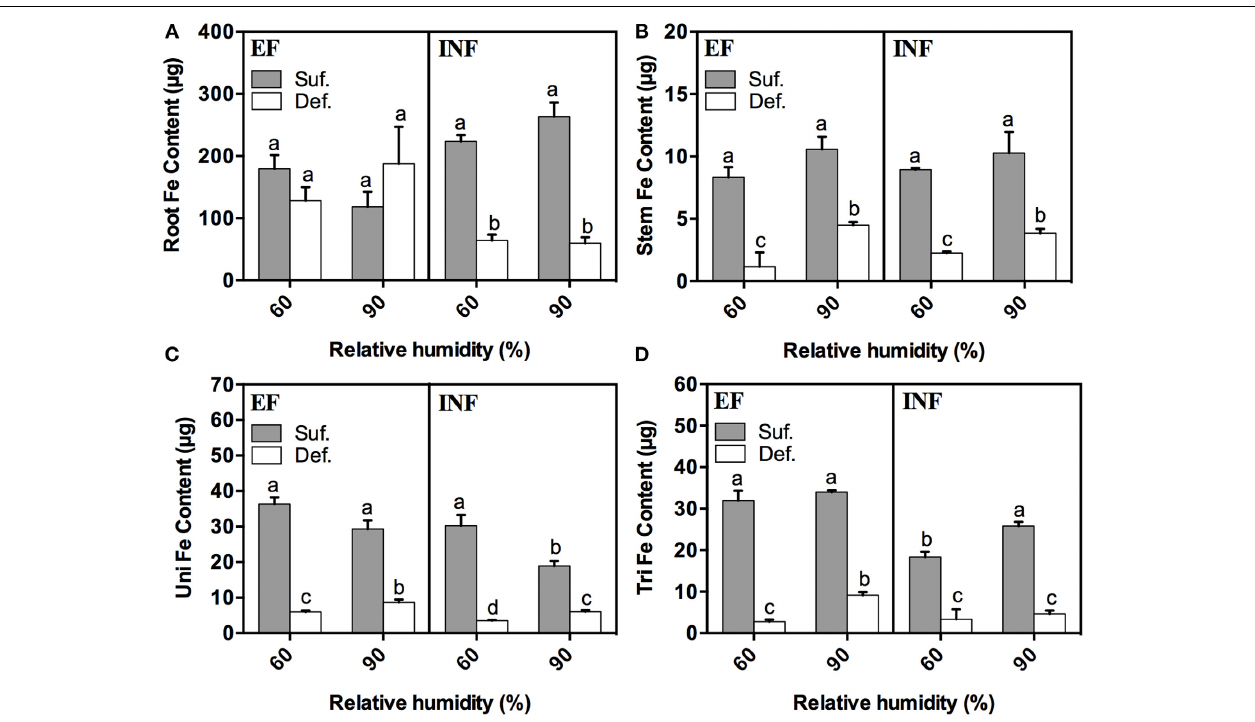
FIGURE 4 | Fe content ( µ g) measured by ICP-OES in 14-day-old roots (A), stems (B), unifoliate (Uni) (C),and trifoliate (Tri) leaves (D) of “Fe-efficient” (EF, PI 360952) and “Fe-inefficient” (INF, PI 407707) accessions and grown at 60% and 90% relative humidity (RH) under